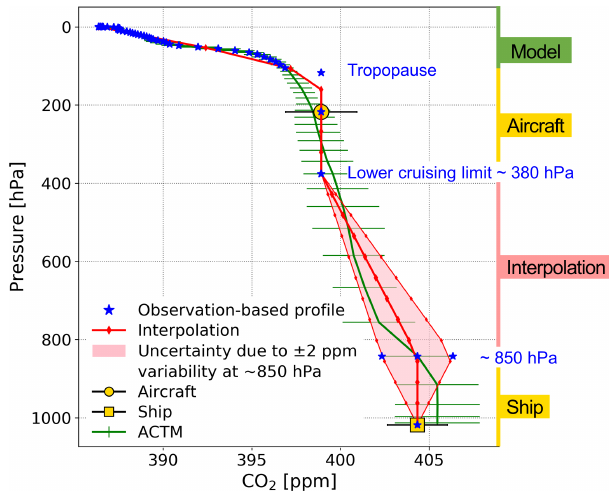
Figure 2. Construction of the observation-based CO 2 profile (blue) obtained by using ship (SOOP) and aircraft (CONTRAIL) data (yel- low) together with the results of the ACTM (green), and the inter- polation (red). The example is obtained at the latitude 20–30 ◦ N, March